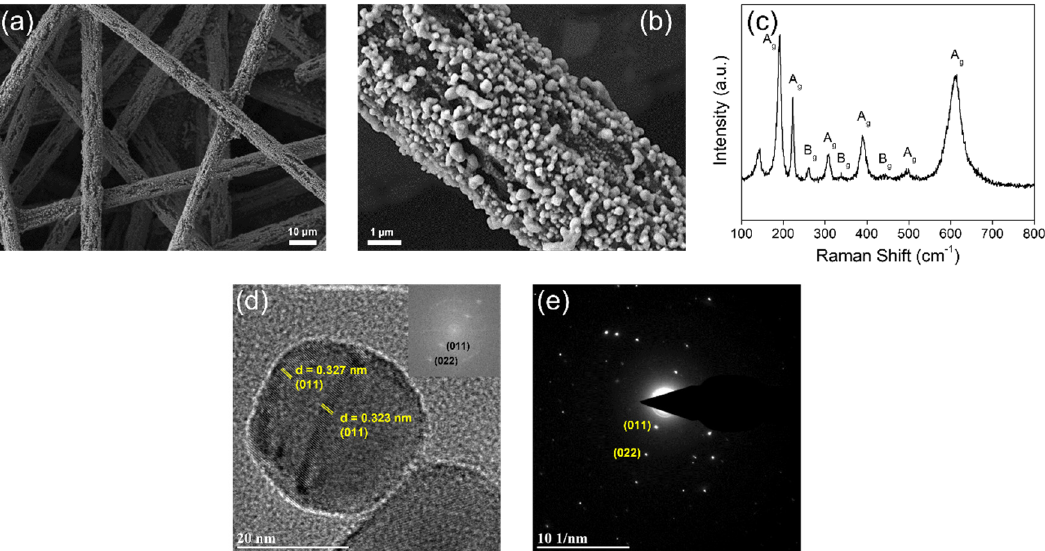
Figure 1. ( a ) a low-magnification and ( b ) high-magnification FESEM images and ( c ) room-temperature Raman spectrum acquired for the VO 2 (M1) nanoparticles formed on carbon fiber paper (514.5 nm laser excitation). ( d ) Lattice-resolved HRTEM image and ( e ) the indexed SAED pattern of the VO 2 (M1) nanoparticles harvested from the VO 2 /CFP sample by ultrasonication for 1 h in toluene. An individual VO 2 (M1) nanoparticle shows an interplanar separation of 0.323–0.327 nm corresponding to the spacing between (200) lattice planes. The inset of ( d ) indicates its fast Fourier transform (FFT) image.